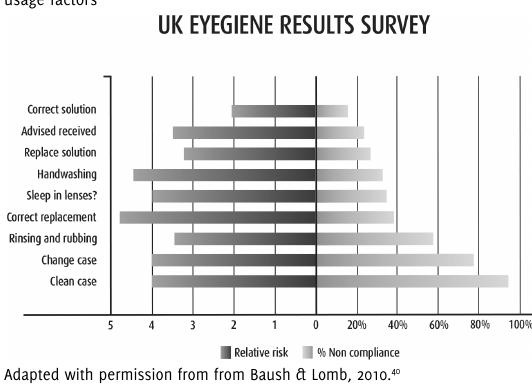
Adapted with permission from from Baush & Lomb, 2010. 40